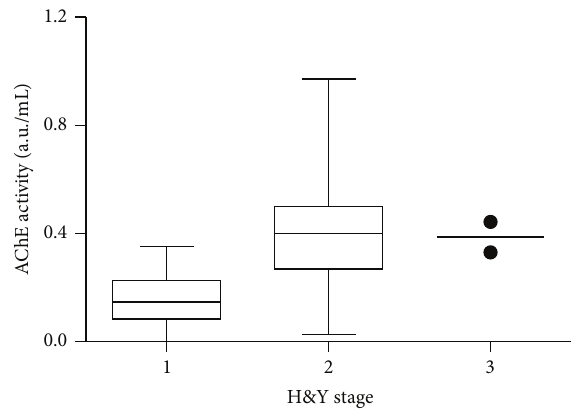
Figure 3: Box-and-whiskers plot of AChE activity in the H&Y sub- groups. The plot shows mean, 25th and 75th percentiles, minimum, and maximum values. The H&Y stage 3 group included only two samples that are represented as